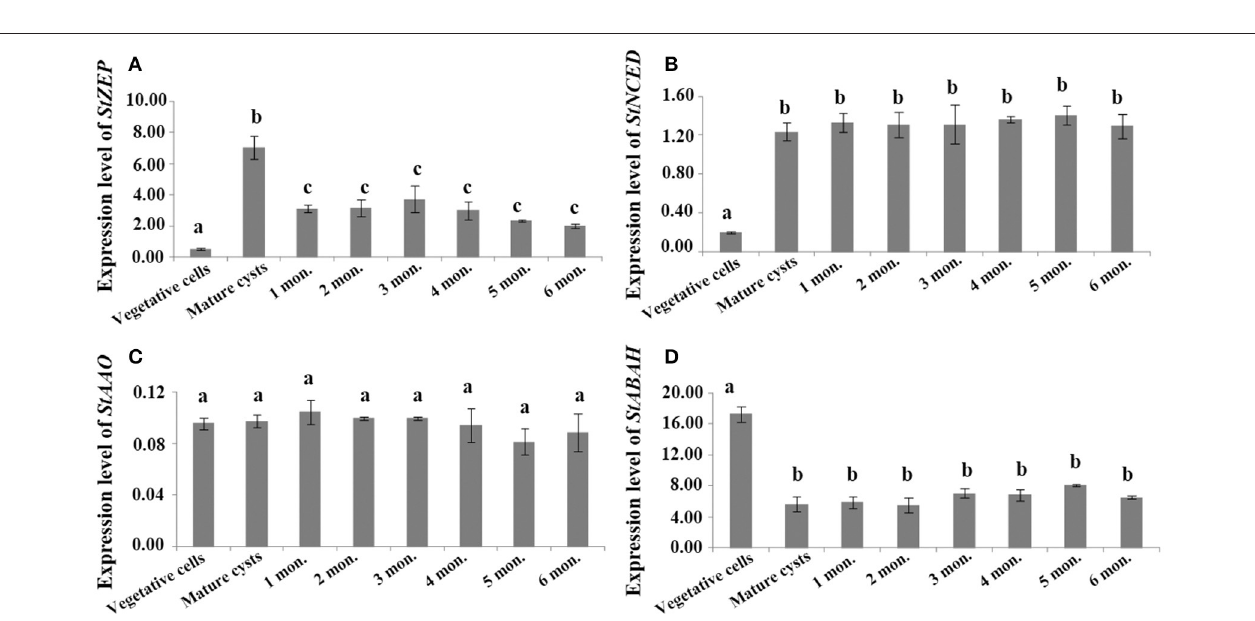
FIGURE 3 | The transcript levels of genes associated with ABA biosynthesis and catabolism, (A) StZEP (B) StNCED (C) StAAO (D) StABAH , relative to MDH (reference gene) in resting cysts maintained at 20 ± 1 ◦ C for different periods of incubation time (0–6 month). The Y axis shows the expression levels of targeted genes relative to the reference gene; Significant differences in abundance are indicated with different letters above bars at p < 0.05; same letter denotes no significant difference. Values are presented as mean ± standard deviation, Error Bars = SD, n = 3.